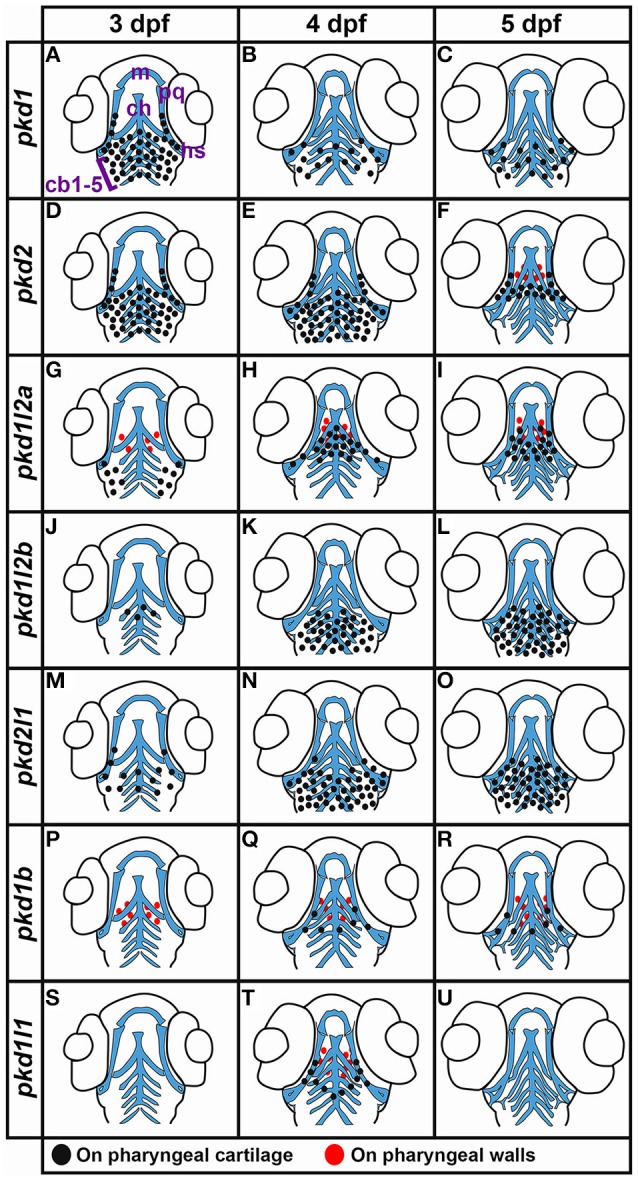
Summary of pkd expression in ventral pharyngeal regions. (A–U) Schematics showing ventral views of zebrafish pharyngeal regions summarizing expression of pkd genes at 3, 4, and 5 dpf. Black dots indicate expression on pharyngeal cartilage and red dots indicate expression on pharyngeal walls. Cartilage schematics are modified from Schilling and Kimmel (1997), Knight et al. (2003), and Edmunds et al. (2016). Locations of the major cartilaginous elements are shown in panel (A). m, Meckel's cartilage (ventral component of lower jaw); ch, ceratohyal cartilage (derived from the second pharyngeal arch); pq, palatoquadrate cartilage (derived from the first pharyngeal arch, forms the dorsal mandibular cartilage); hs, hyosymplectic cartilage (also derived from the second pharyngeal arch); cb1–5, ceratobranchial cartilage 1–5 (forms the ventral branchial or gill arches).